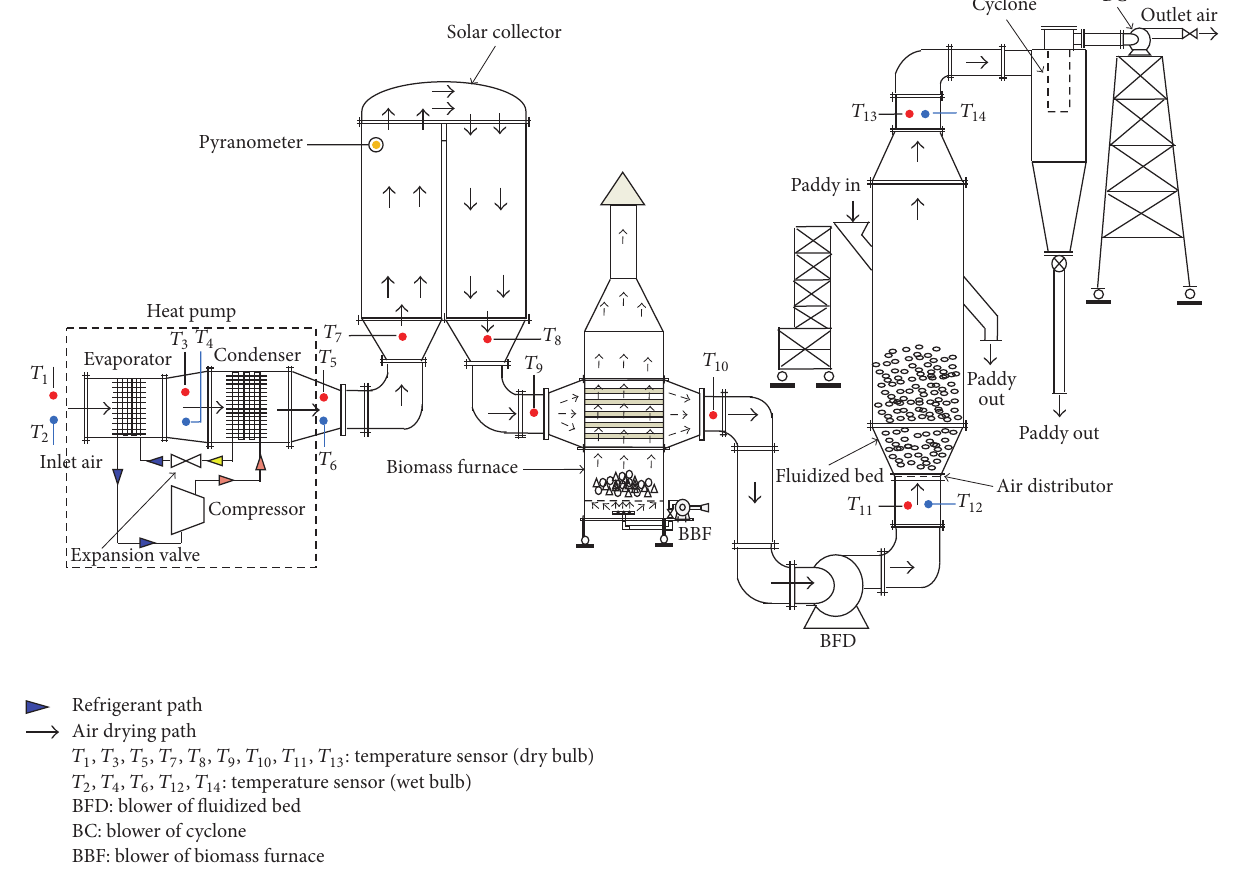
Figure 8: Schematic diagram of SAHP-FBDIBF (mode